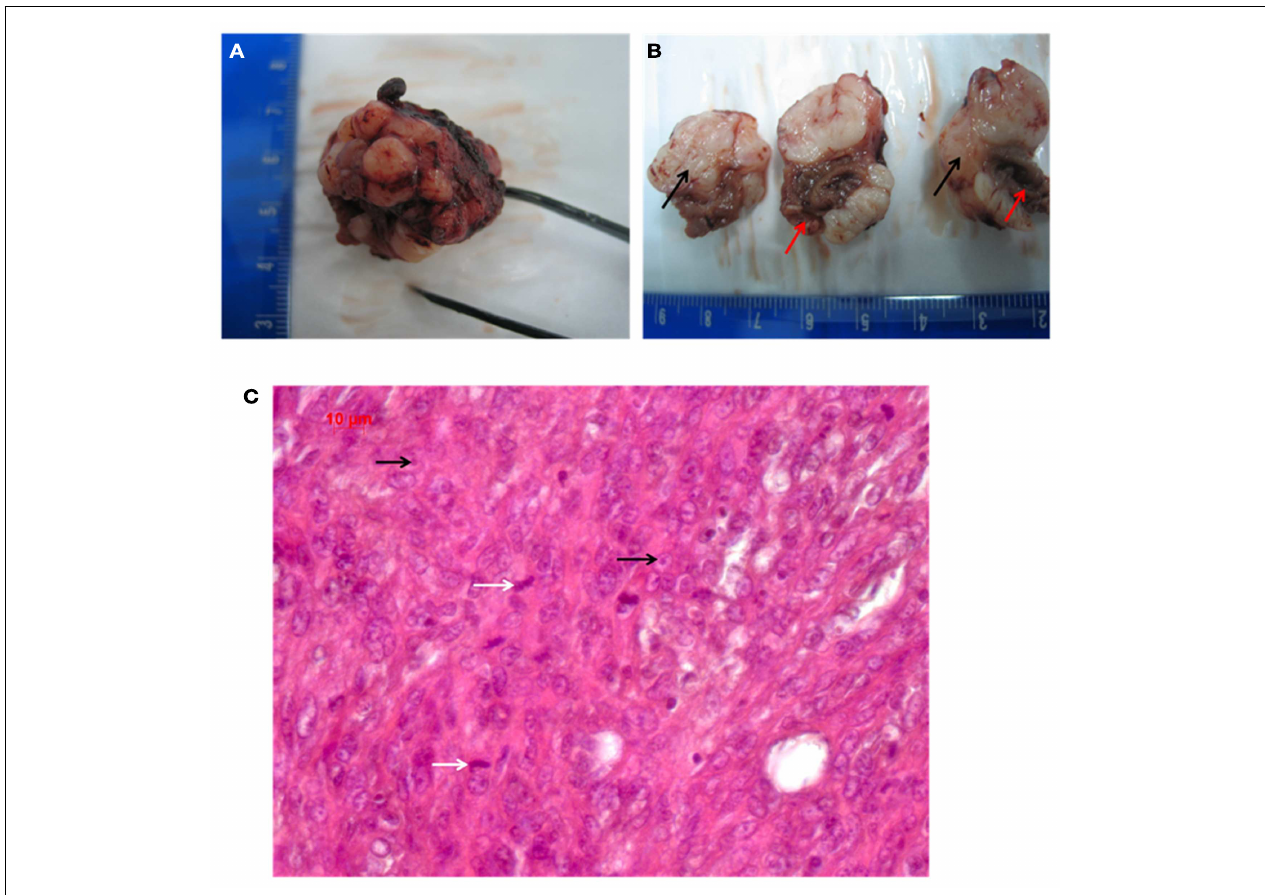
FIGURE 2 | (A,B) Macroscopic pathology of the tumor (red arrows point to the heart, black arrows indicate the grayish tumor mass). (C) Shows the HE histology (white arrows indicate mitosis; black arrows point to nucleoli).